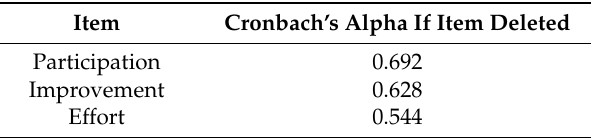
Table 2. PIE scale: (Cronbach’s alpha